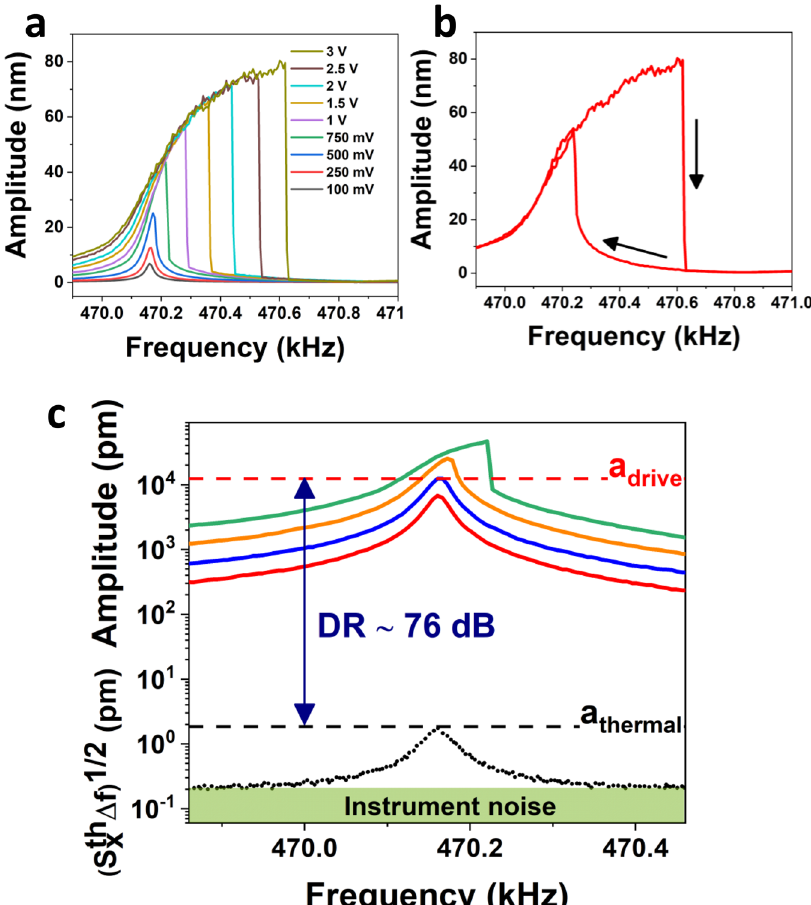
Fig. 5 Dynamic range of 3D printed devices. a Amplitude spectra of cantilever device for different piezodisk driving voltages. Above 750 mV, resonance curves show Duf fi ng lineshape due to geometrical nonlinearity. b Nonlinear resonance frequency dependence over frequency sweep direction (indicated by the arrows). c Dynamic range of 3D printed cantilever between the amplitude of thermal noise spectrum and maximum linear driven